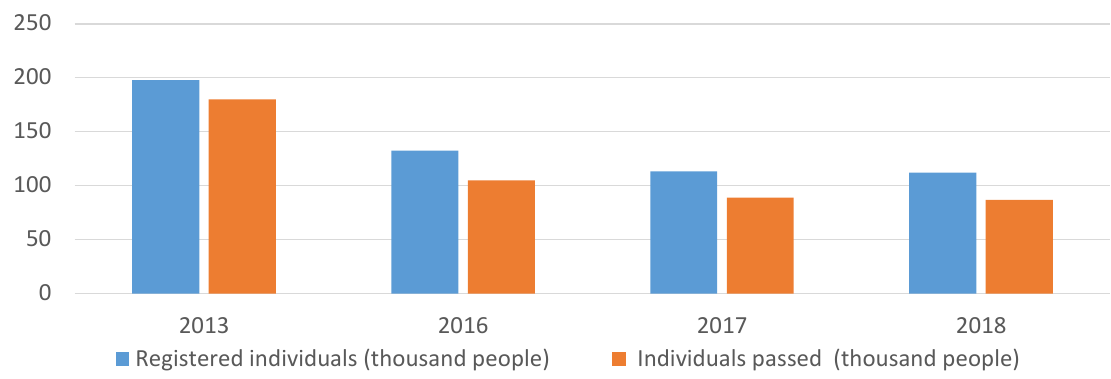
Source: Developed by the authors on the basis of Український центр оцінювання якості освіти [Ukrainskyi tsentr otsiniuvania yakosti osvity]